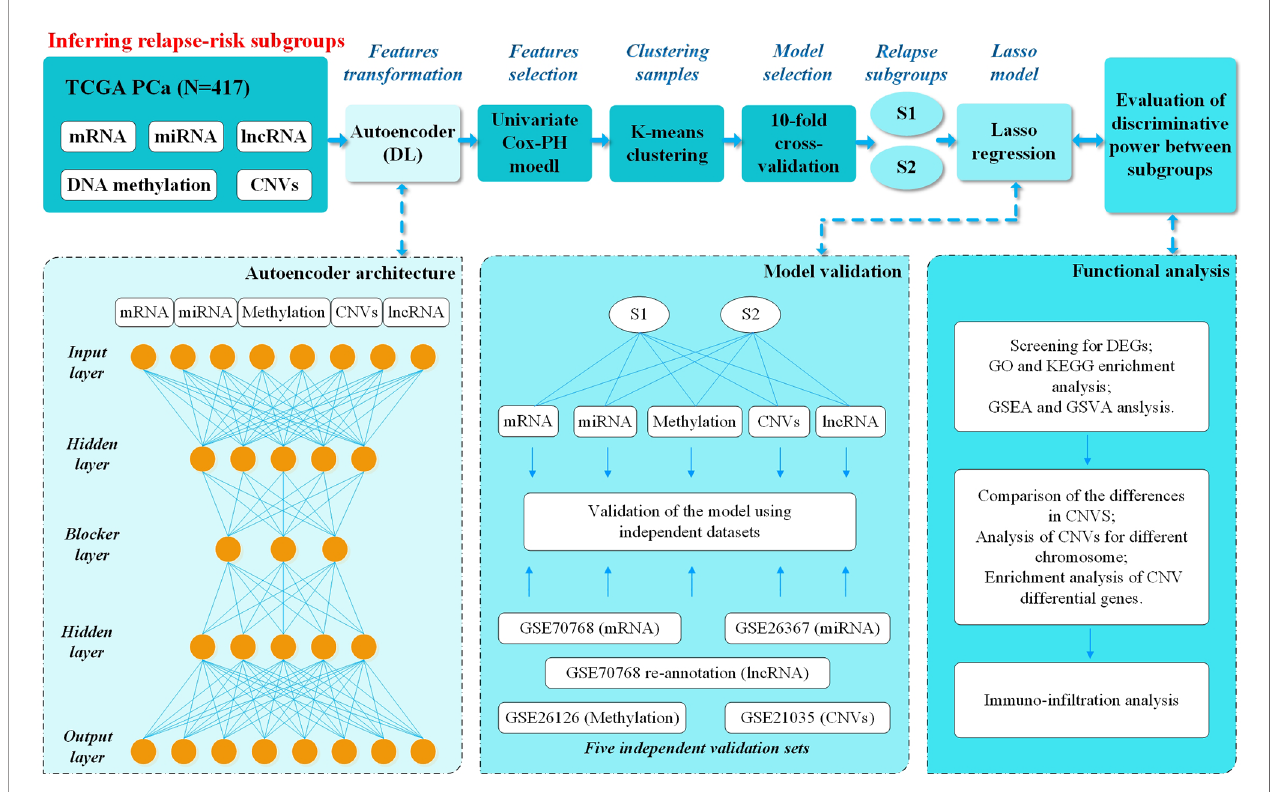
FIGURE 1 | Overall work fl ow. Firstly, mRNA, miRNA, DNA methylation, CNVs, and lncRNA deep features from the TCGA PCa cohort were stacked up as input features for the autoencoder, a deep-learning method. Then each of the new and transformed features in the bottleneck layer of the autoencoder were subjected to univariate Cox-PH models to select the features associated with relapse. Then K-mean clustering was applied to relapse-associated deep features and 10-fold cross-validation was applied to analyze the C-index for different clusters and relapse in 8 DL models. The best model (model_3) with better discriminative ability was fi nally selected using Kaplan-Meier plotter between two models with the highest C-index. Then the Lasso method was used to fi lter out the relapse-associated feature labels, according to model_3 subgroups, from the database of TCGA, including mRNA, miRNA, DNA methylation, CNVs and lncRNA. The Lasso model was constructed, and fi ve external validation sets from GEO were used to evaluate its prediction ability. Last but not least, functional analysis was performed to understand the different characteristics between two relapse-associated